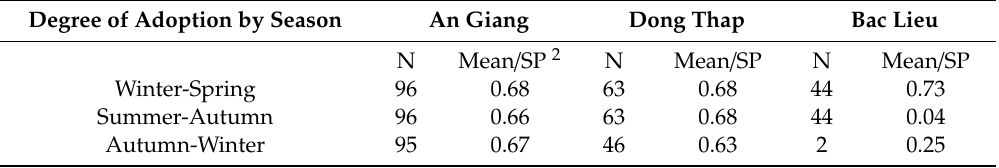
Table 2. Adoption rates in three provinces of the Mekong River Delta. 1